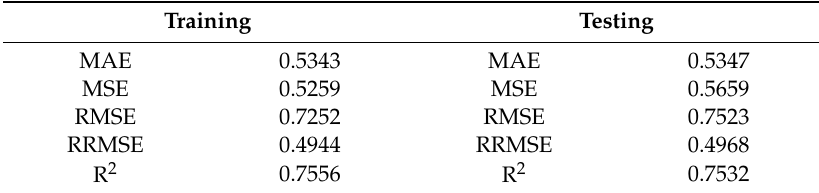
Table 5. Results of slope deformation of earth dam predicted by the MARS model based on the piecewise-cubic method.